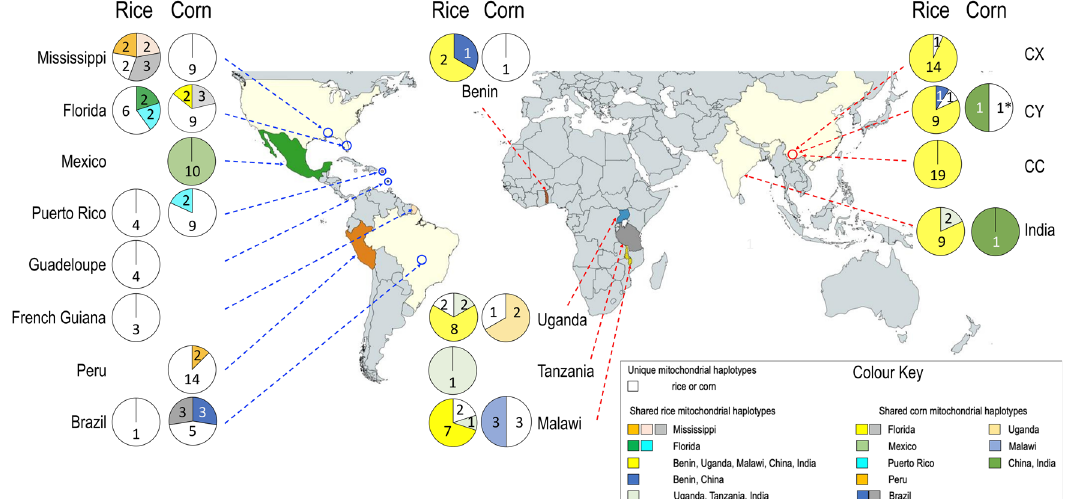
Fig. 1 Native New World and invasive Old World FAW populations, and proportions of rice-strain and corn-strain mitochondrial DNA haplotypes from 15,059bp of the mitochondrial DNA genomes. New and Old Worlds ’ FAW populations and proportions of mitochondrial DNA haplotypes based on 15,059 bp of the mitochondrial DNA genomes and excluding four regions of low complexity. For the New World ‘ rice ’ FAW, a total of 20 unique mitogenome haplotypes (represented by the white colour proportion of each pie chart), and 11 non-unique mitogenome haplotypes were detected (i.e., a total of 25 mitochondrial haplotypes in rice FAW in the New World). For the ‘ corn ’ mitogenomes, 46 unique haplotypes were detected from the native range, while 25 corn FAW individuals shared a total of seven haplotypes (i.e., a total of 46 + 7 = 53 mitochondrial haplotypes). In the invasive range, six unique ‘ rice ’ mitogenomes (i.e., white portion of the pie charts, representing two individuals from Uganda, two individuals from Malawi, and two individuals from China (CY, n = 1; CX, n = 1) and three shared mitogenomes (i.e., dark blue, yellow, pale green) were detected from 76 individuals from Africa ( n = 22), India ( n = 11) and China ( n = 43). For the ‘ corn ’ FAW from the invasive range, six unique mitogenome haplotypes (i.e., white portions of pie charts) and three non-unique mitogenome haplotypes (pale orange, pale blue and dark green) were detected, although only one individual each from China and India shared a common mitogenome (represented by dark green). With the exception of white colour representing unique mitogenomes, colour schemes are otherwise independent between ‘ corn ’ and ‘ rice ’ mitogenome haplotypes. China FAW populations from Yunnan Province of Cangyuan (CC), Yuanjiang (CY), and Xinping (CX) are indicated. One pre-border FAW intercepted in December 2016 from cut fl owers that originated from Yunnan China (CH06) with a unique corn mitogenome is indicated with ‘ * ’ (placed together with the CY corn pie-chart). Numbers within pie-charts indicate individuals for each mitogenome